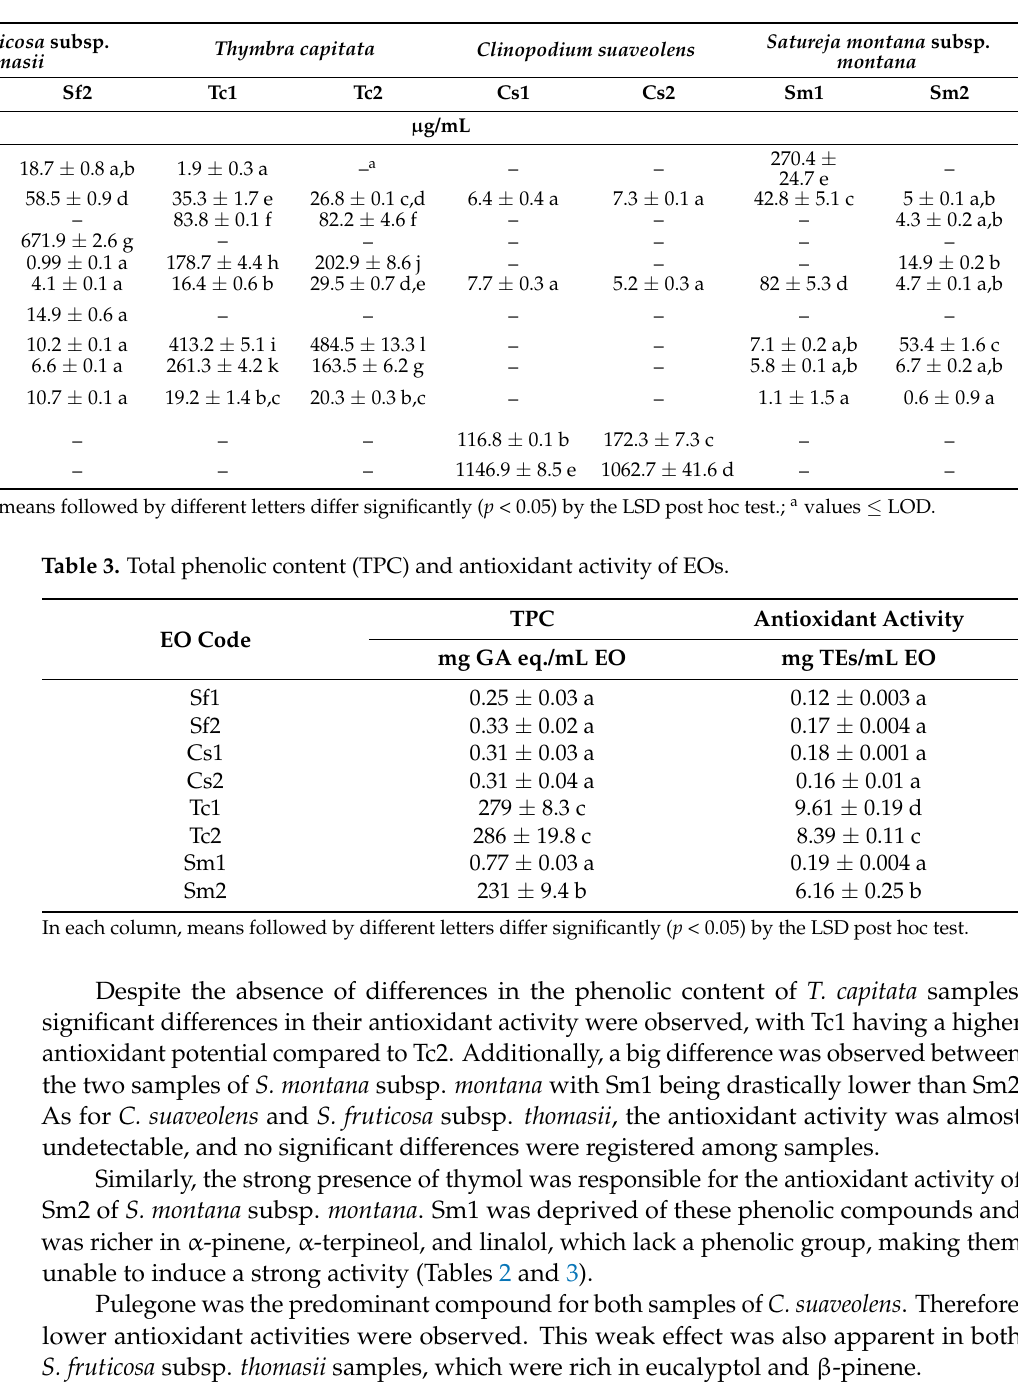
Table 2. Concentrations ( µ g/mL) of the most abundant compounds occurring in the EOs, identified and quantified by GC-MS.